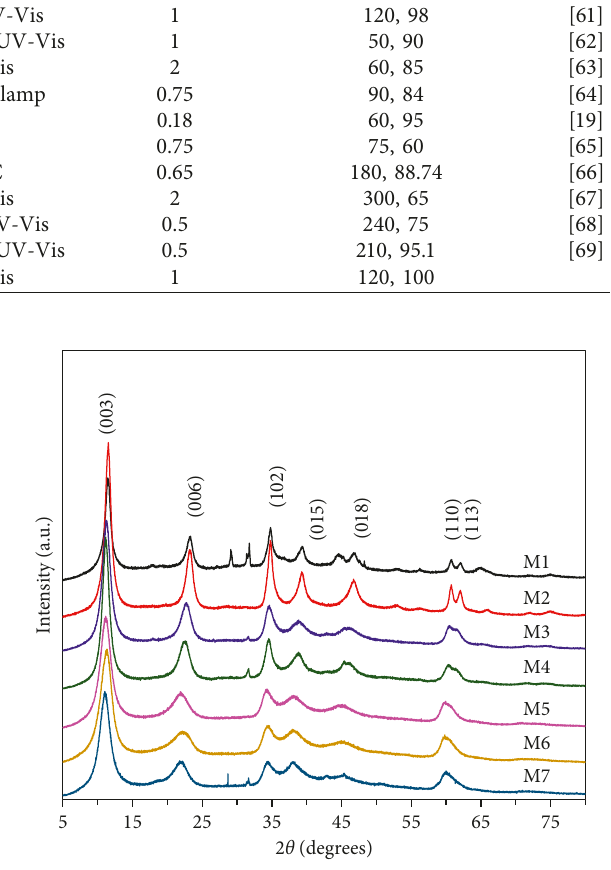
Figure 17: X-ray diffraction of Mg/Al hydrotalcites reconstructed after photodegradation of 2,4,6-trichlorophenol.